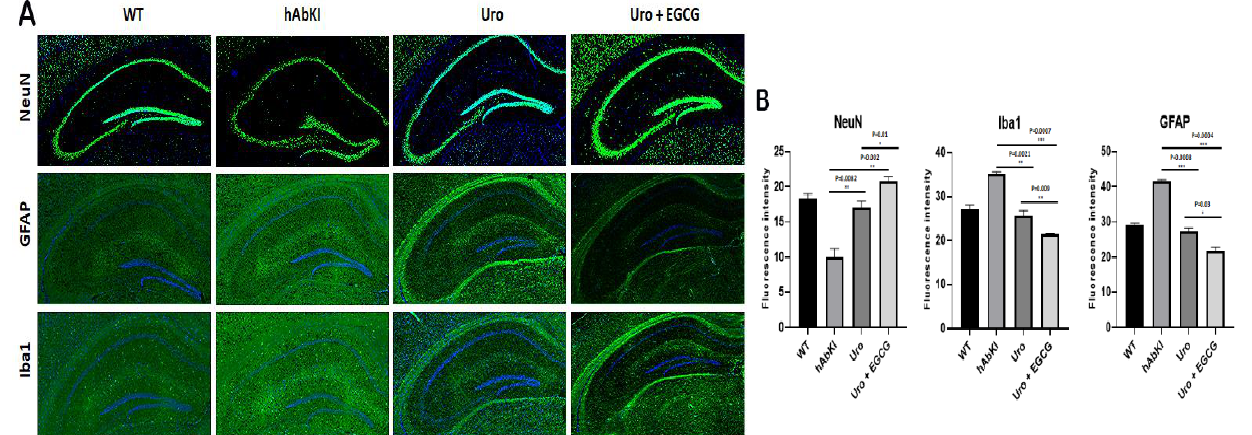
Figure 11. Immunofluorescence analysis of hippocampal microglial, astrocytic and neuronal proteins in seven-month-old hAbKI mice and treated hAbKI mice with Urolithin A and EGCG. ( A ) Representative immunofluorescence images and ( B ) quantitative immunofluorescence analysis of microglial Iba1 and astrocytic protein GFAP and neuronal protein NeuN in hAbKI mice relative to treated hAbKI mice with Urolithin A and EGCG.